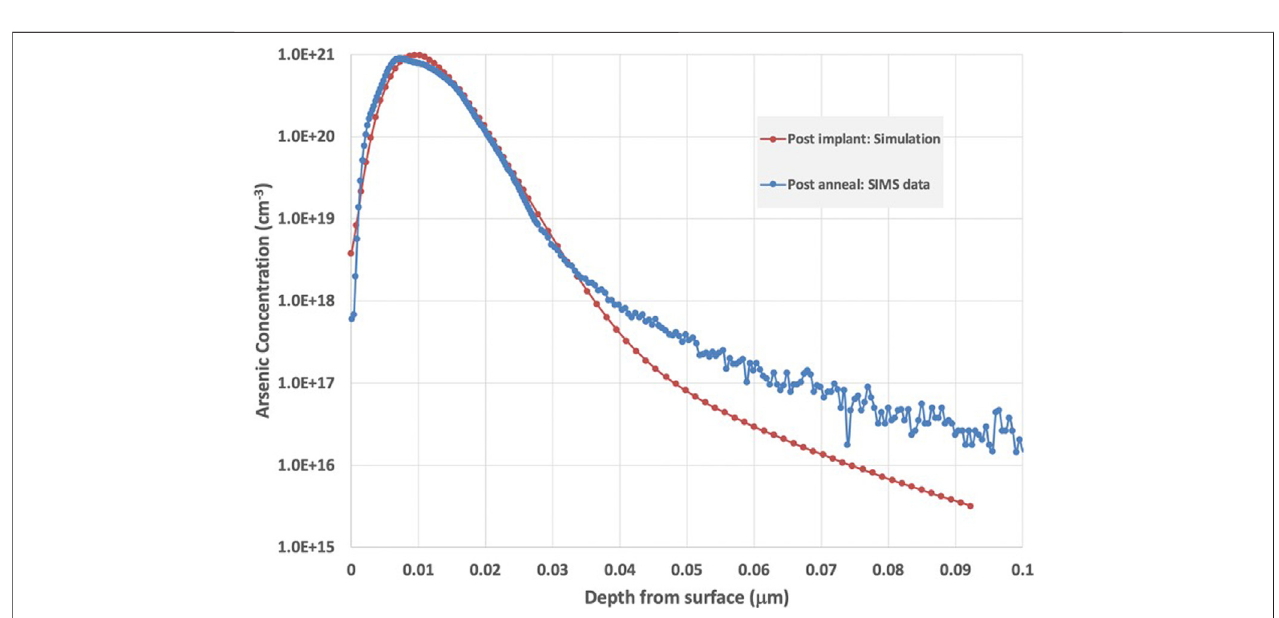
FIGURE 1 | Pro fi le for 10 KeV Arsenic implant: process simulation of post-implanted pro fi le, and experimental results (SIMS data) for the same implant after microwave anneal.